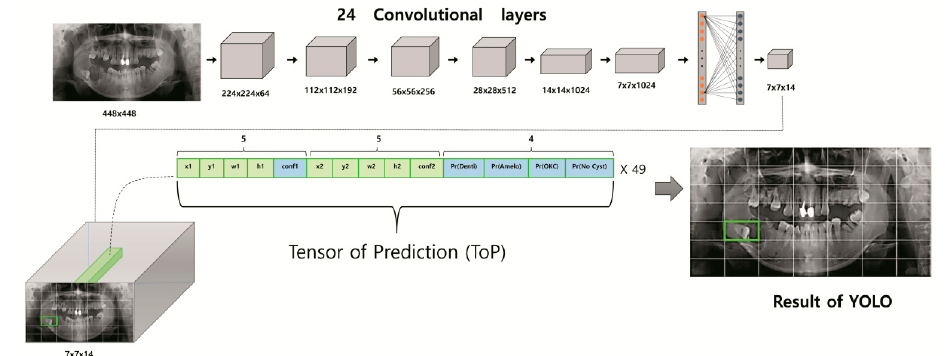
Figure 2. Schematic diagram of You Only Look Once (YOLO)-based computer-assisted diagnosis (CAD) structure.